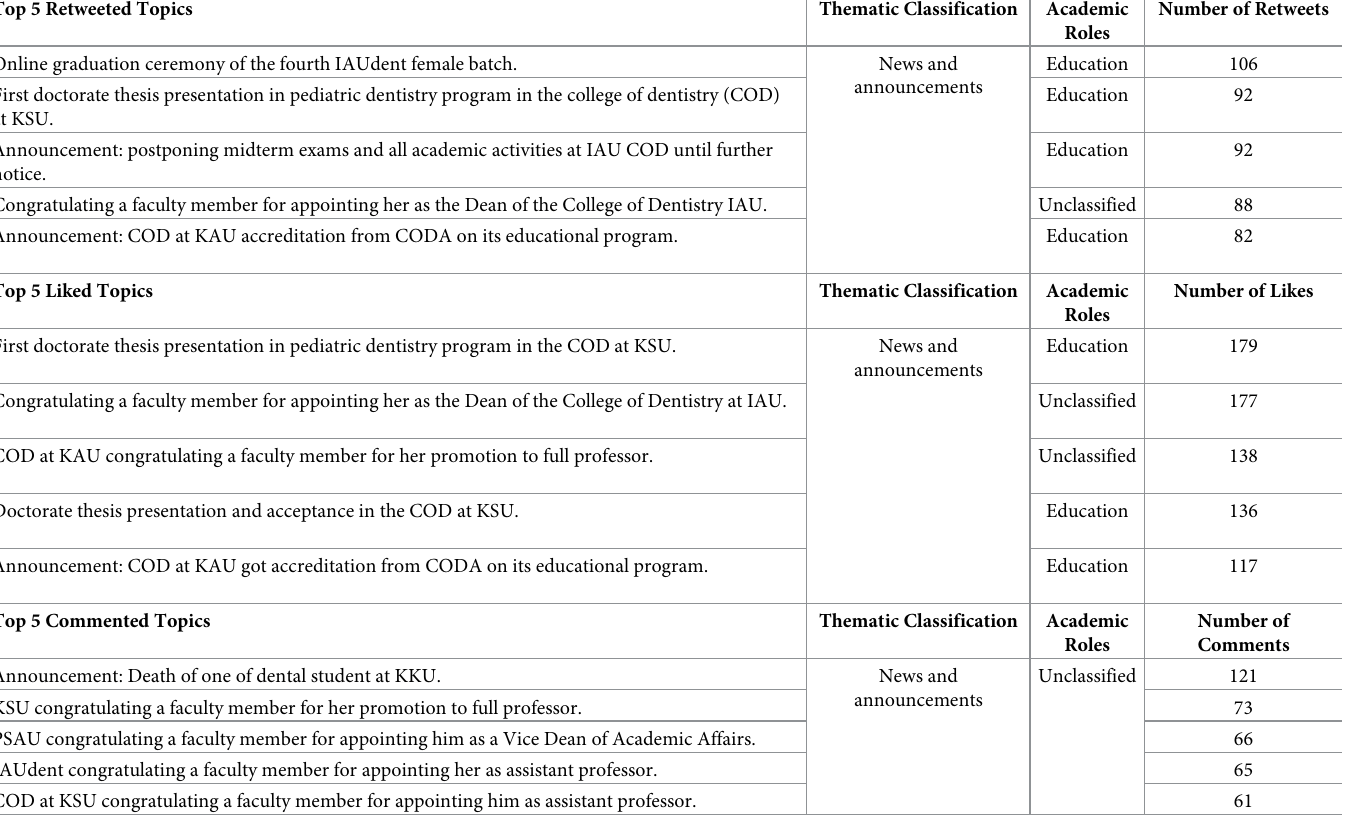
Table 5. Top five retweeted, liked and commented topics for all dental schools. Top 5 Retweeted